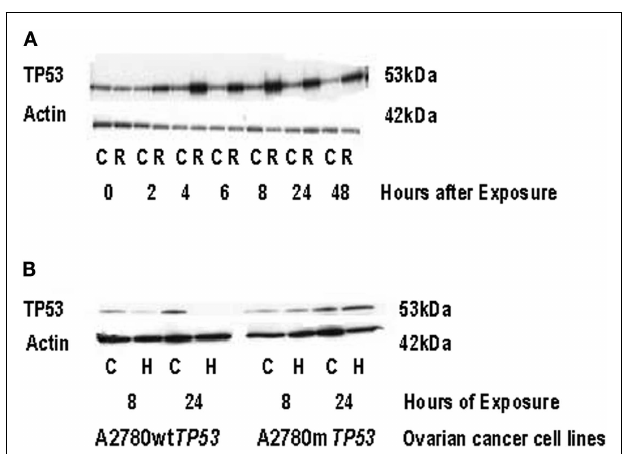
FIGURE 5 |TP53 protein expression in ovarian cancer cell lines following radiation and hypoxia treatment . (A) Induction ofTP53 protein expression in A2780wt TP53 cells following radiation treatment. Irradiated cells demonstrated a 3.3-fold increase inTP53 expression at 48h compared to non-irradiated cells. (B) Induction of p53 protein expression in the parent A2780wt TP53 cells and A2780m TP53 cells following hypoxia exposure. TP53 exposure was absent in the A2780wt TP53 cells at 24h of hypoxia exposure.There was no significant increase in p53 expression in the A2780m TP53 cells after hypoxia. C, control; R, radiation; H,